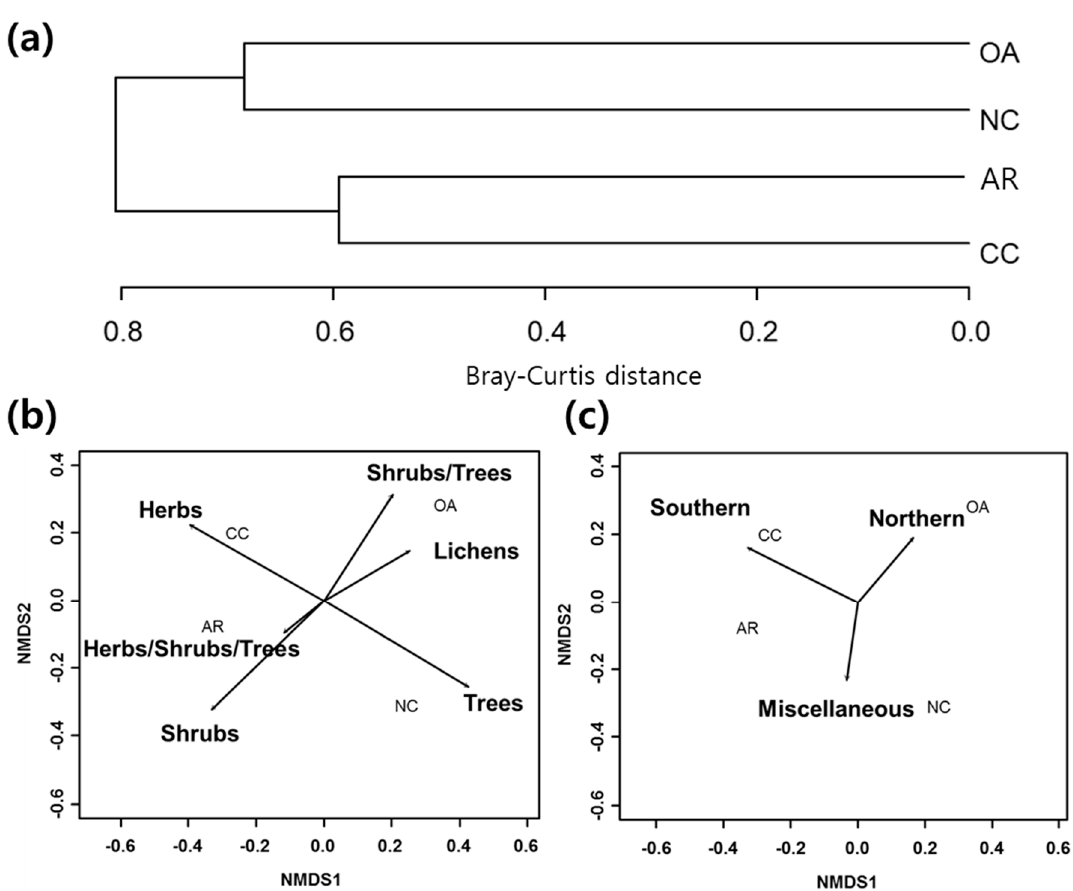
Figure 6. ( a ) Cluster analysis of the four treatment stands based on the abundance of moth communities using Ward’s linkage methods with Bray-Curtis distance measure. ( b , c ) Ordination of non-metric multidimensional scaling (NMDS) using the same data used in the cluster analysis (stress value for the first two axes = 0.01). The abundance proportion of each functional group for host plants ( b ) and distribution patterns ( c ) is presented in the NMDS. CC: clearcutting area; AR: aggregated retention area; NC: no cutting area; OA: Mongolian oak area.